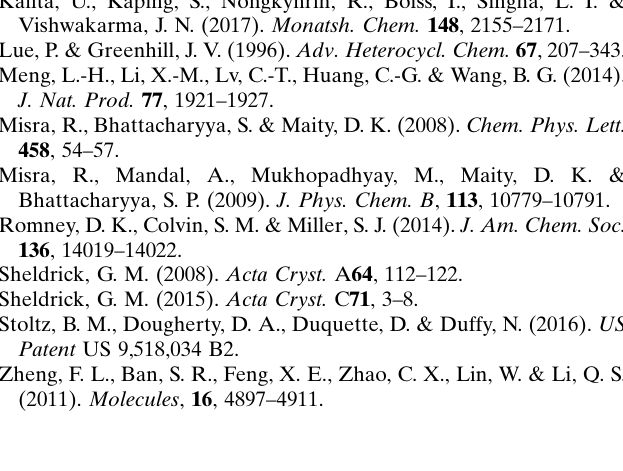
Crystal data Chemical